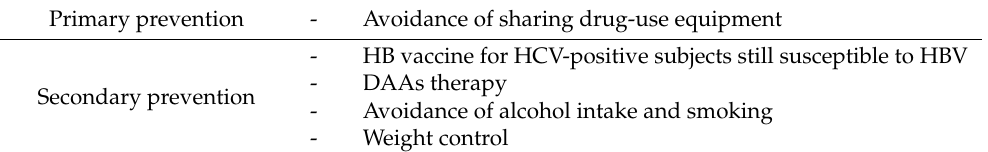
Table 5. Preventive measures for HCV-related HCC. IDU: injecting drugs users. DAAs: Direct Antiviral